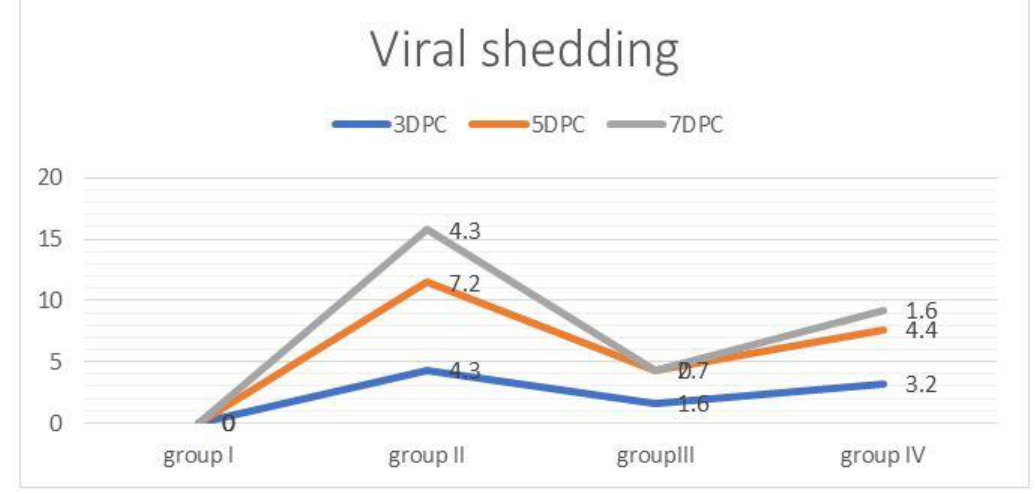
Fig. 5: Efficacy of ECV extract on viral shedding at three-time intervals in the prophylactic group (III) and therapeutic group (IV), and control group (I) and (II)